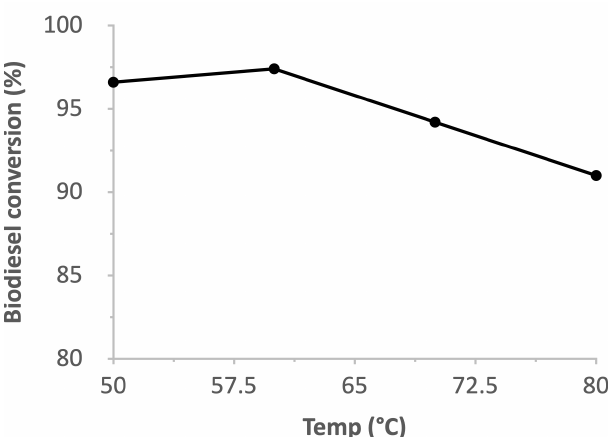
Figure 12. Effect of temperature on biodiesel